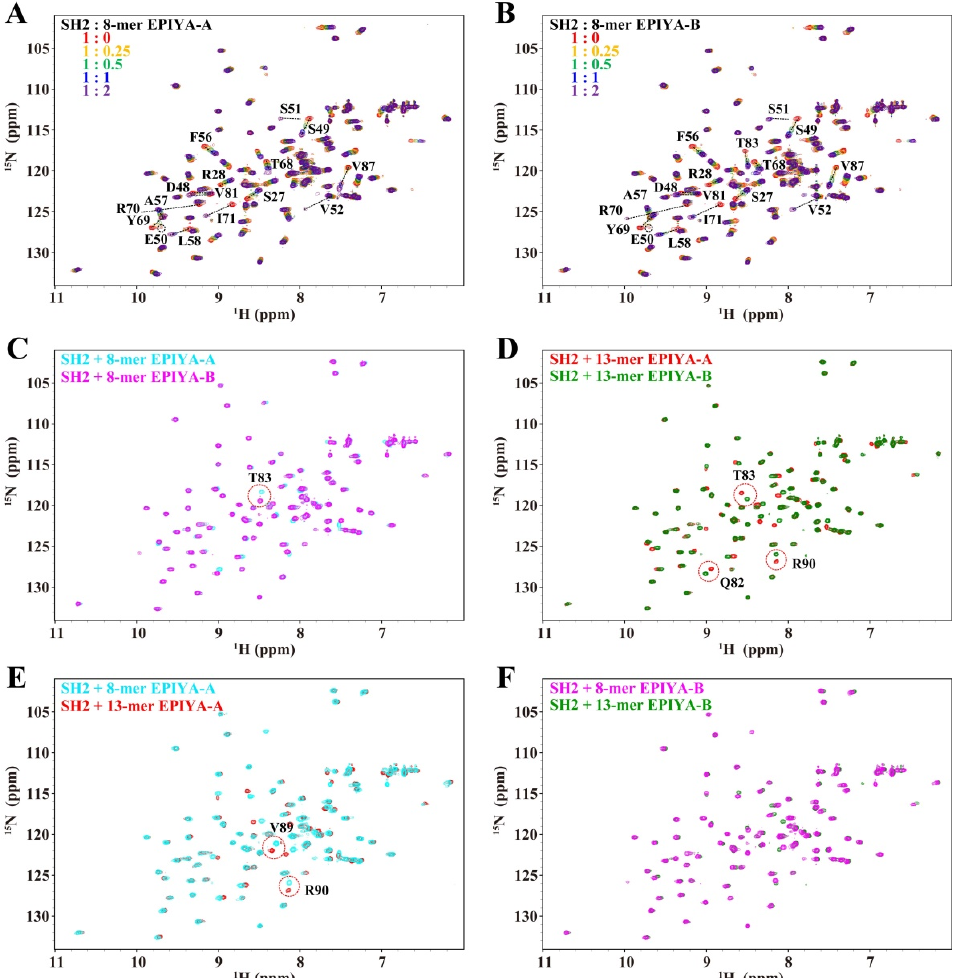
Figure 4. SHIP2-SH2 interacts with Tyr-phosphorylated CagA EPIYA-A and EPIYA-B motifs. NMR titrations of SHIP2-SH2 by 8-mer Tyr-phosphorylated CagA EPIYA-A ( A ) and EPIYA-B ( B ) peptide. The residues with remarkable chemical shift perturbations are labeled. ( C ) Superposed spectra of SHIP2-SH2 bound by Tyr-phosphorylated 8-mer EPIYA-A and EPIYA-B peptides. ( D ) Superposed spectra of SHIP2-SH2 bound by Tyr-phosphorylated 13-mer EPIYA-A and EPIYA-B peptides. ( E ) Superposed spectra of SHIP2-SH2 bound by Tyr-phosphorylated 8-mer and 13-mer EPIYA-A peptides. ( F ) Superposed spectra of SHIP2-SH2 bound by Tyr-phosphorylated 8-mer and 13-mer EPIYA-B peptides. The residues with chemical shift differences larger than 0.15 ppm are highlighted by red circles.